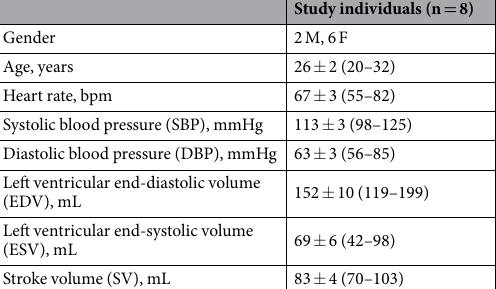
Study individuals (n = 8)